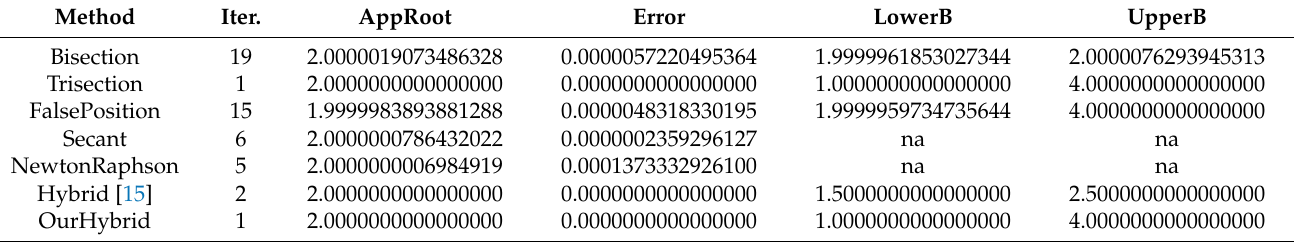
Table 2. Comparison among pure methods and blended algorithms according to iterations, AppRoot, error and interval bounds.